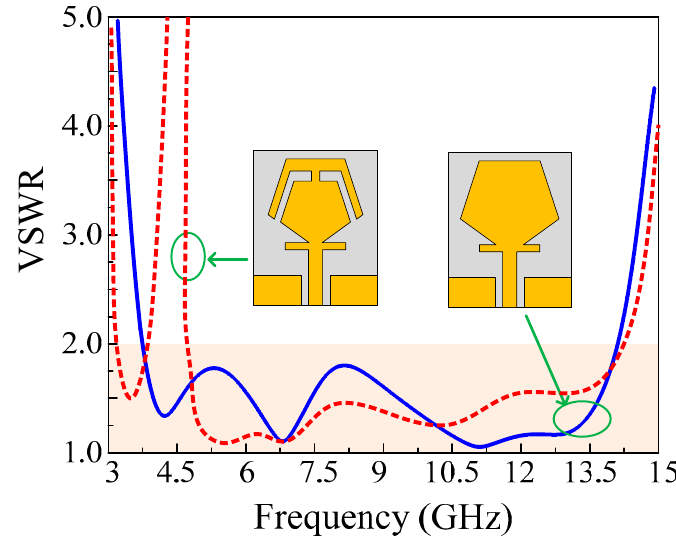
Figure 5. VSWR of the radiating element before and after the slots.